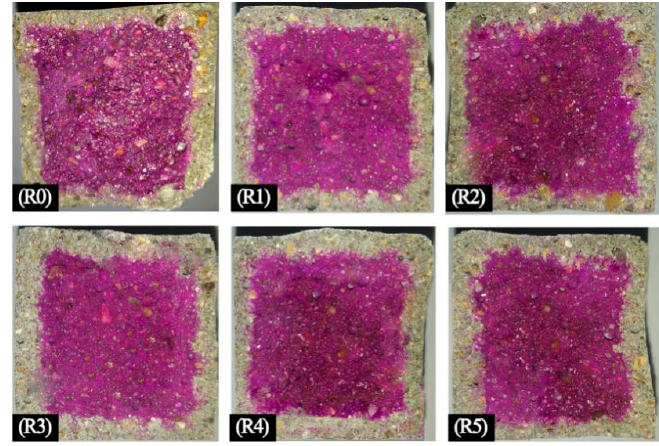
Figure 3. Image of carbonation depth under mechanical agitation (7 d).